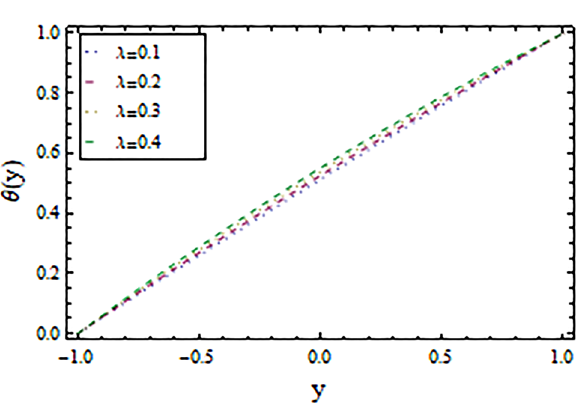
Figure 8. Temperature distribution for A = 0.002, B = 0.01and M = 0.002 using